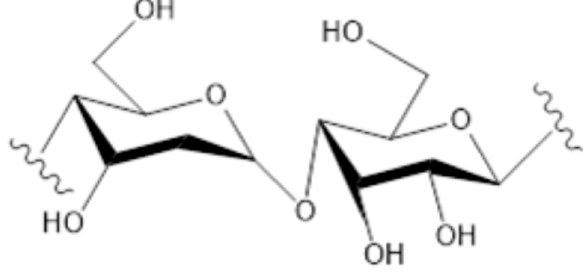
Figure 13. Polysaccharide molecule.